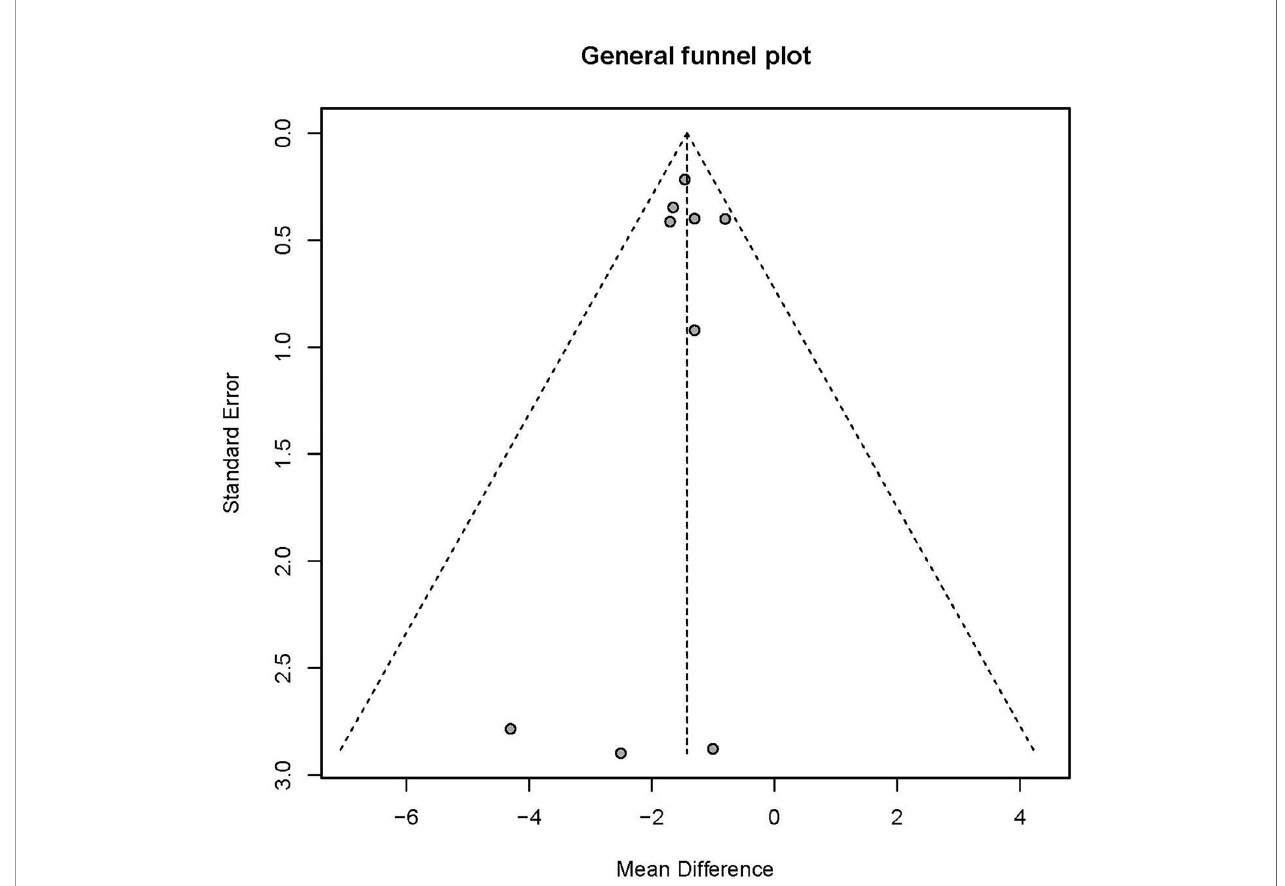
FIGURE 2 | General funnel plot analysis.